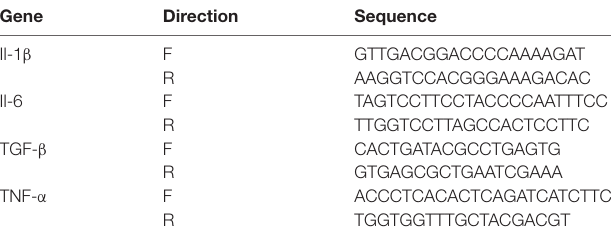
TABLE 1 | Primers used for